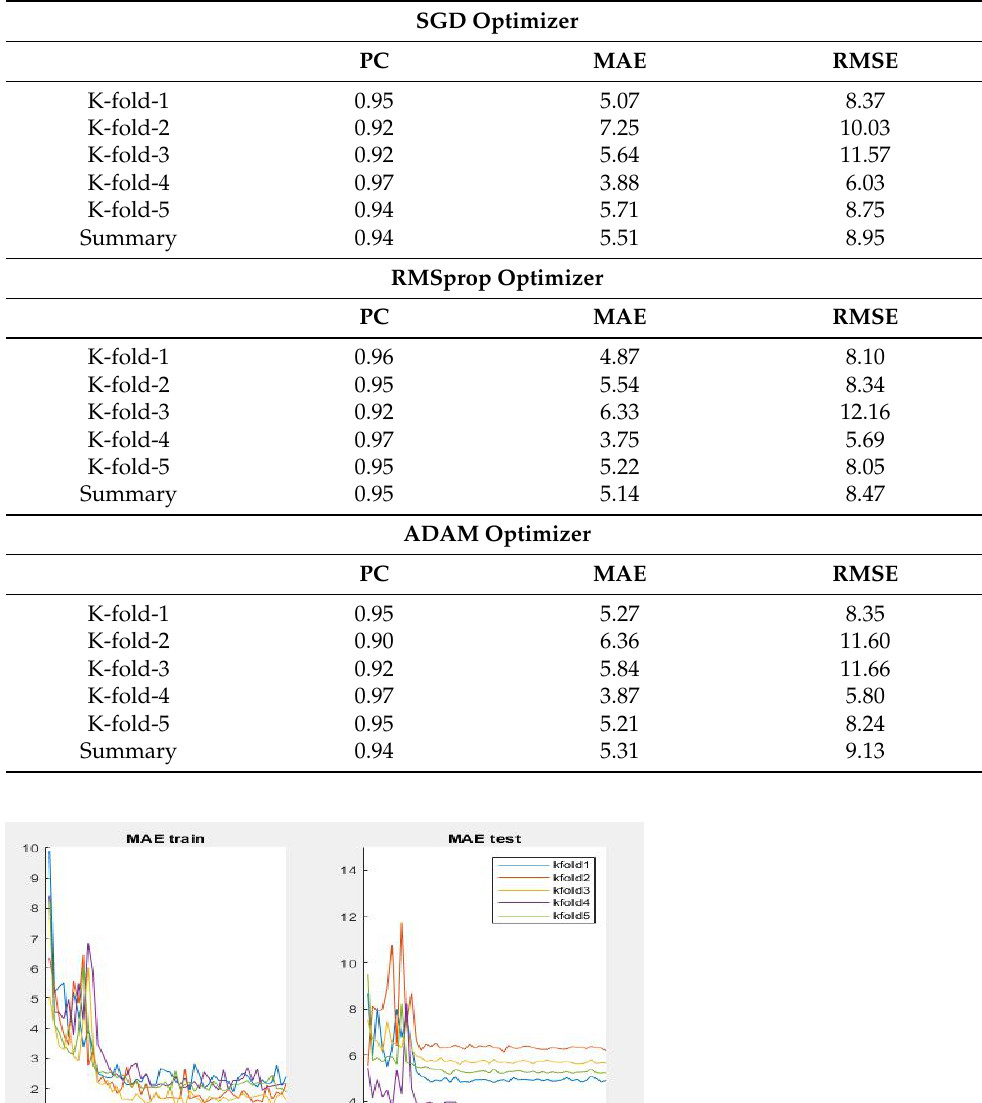
Table 3. Results of the second stage in the testing phase using CNN Densenet-161, with three different optimizers and loss functions MSE.